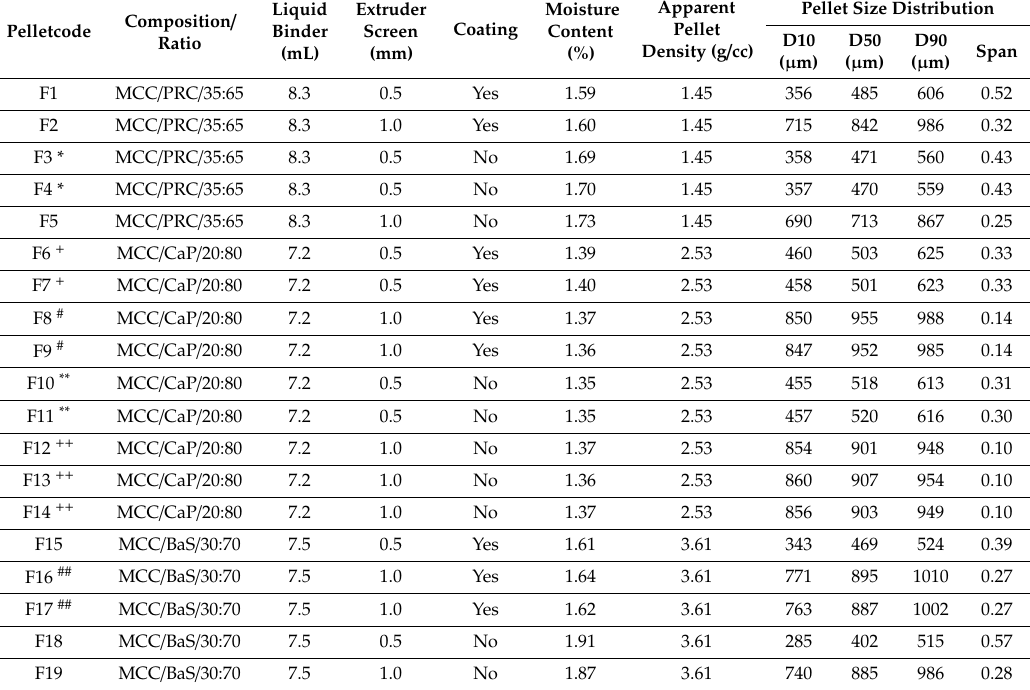
Table 1. Pellet code, composition, consumption per 20 g solids, orifice of extruder screen, coating application, and particulate properties of the experimental pellets. Presentation follows L-optimal experimental